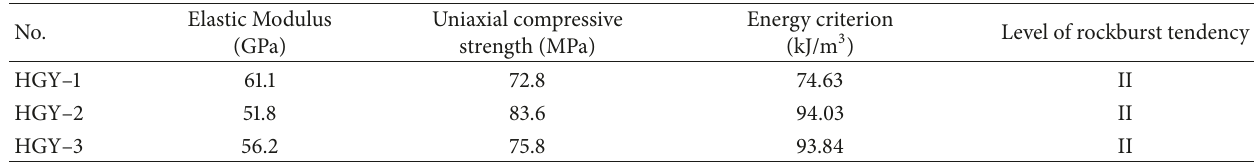
Table 1: Rockburst proneness of granite samples.